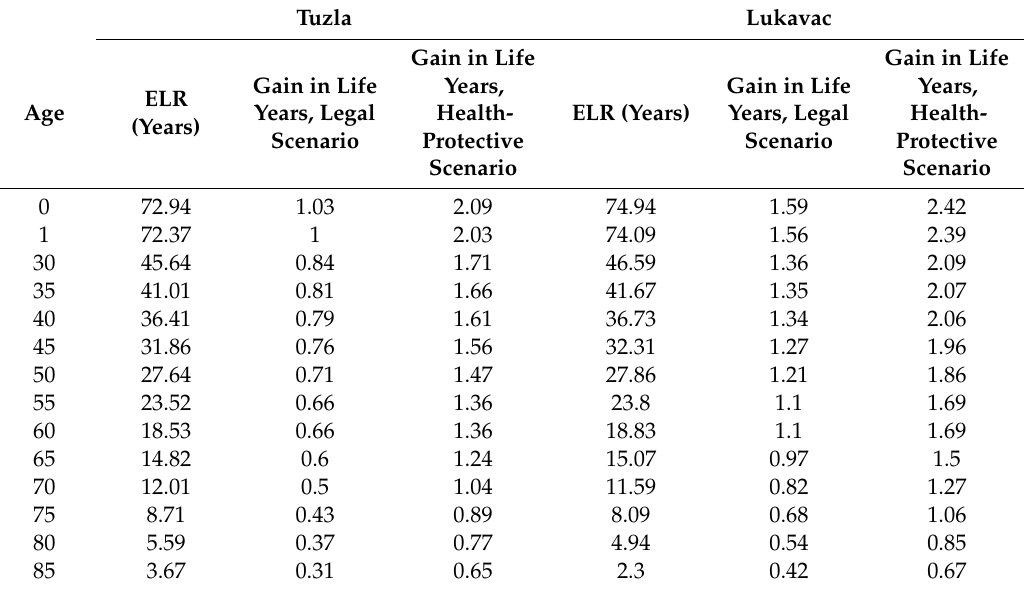
Table 7. Expected life remaining (ELR) and gain, in years, under the legal and health-protective scenario for Tuzla and